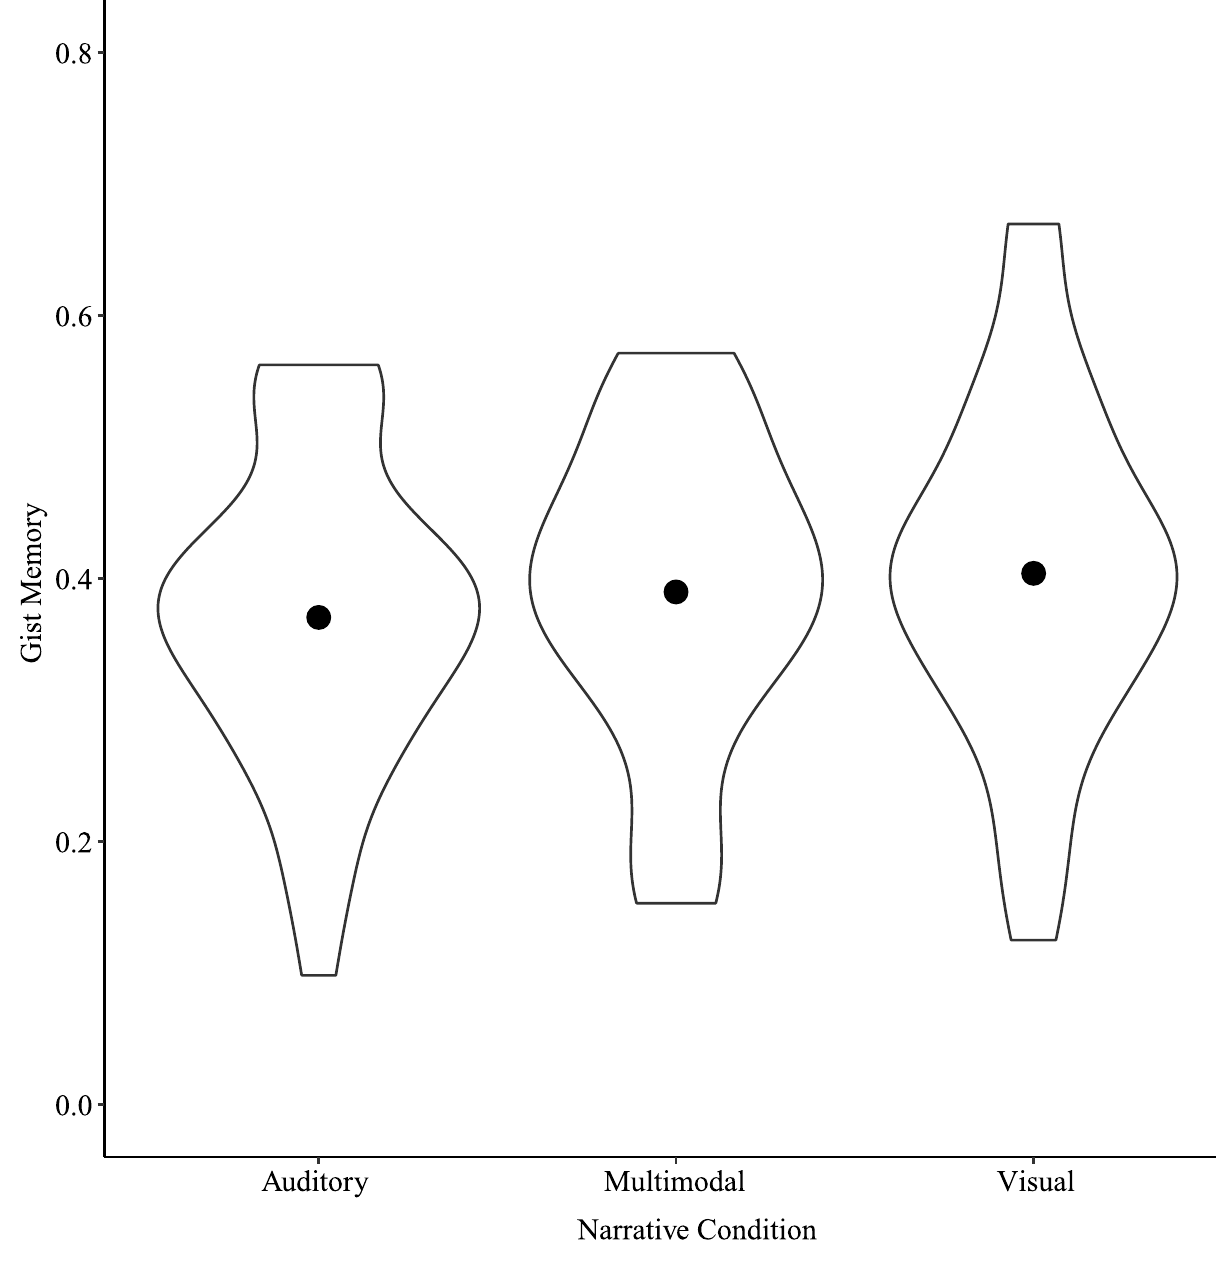
Fig 6. Gist memory by Narrative Condition for Study 2. Points show means for each Narrative Condition.